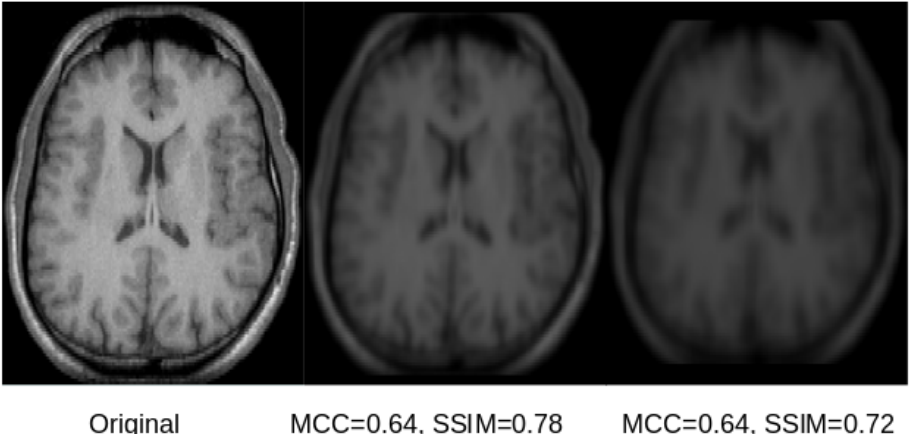
Figure 6. A selected slice from an original MRI dataset without skull stripping ( left ) and its recon- struction from the latent space of the U-Net ( center ) and SegNet ( right ). As can be observed in the image, the original and the reconstructed images are overall similar. However, the reconstruction from the SegNet model is more blurry, which is reflected by lower a SSIM score, while the MCC is very similar for both reconstructions, not reflecting the differences in reconstruction quality.